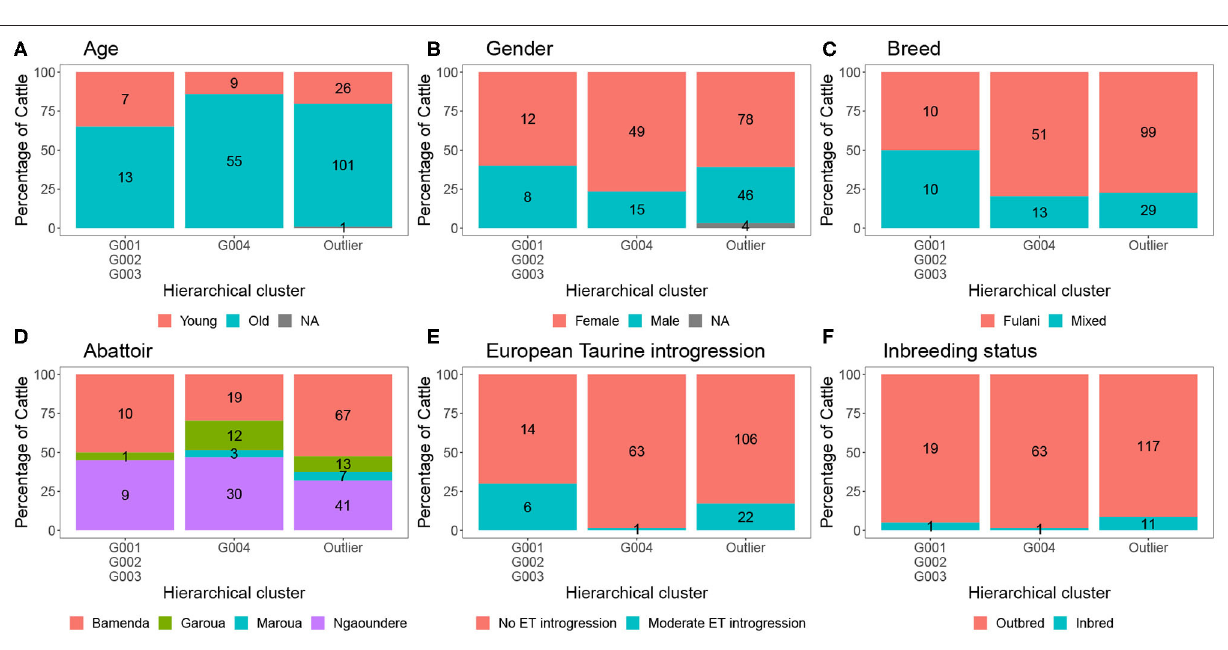
endemic areas of Kenya are tolerant to East Coast fever (Roberts and Gray, 1973; Coetzer and Tustin, 2004; Brown et al.,